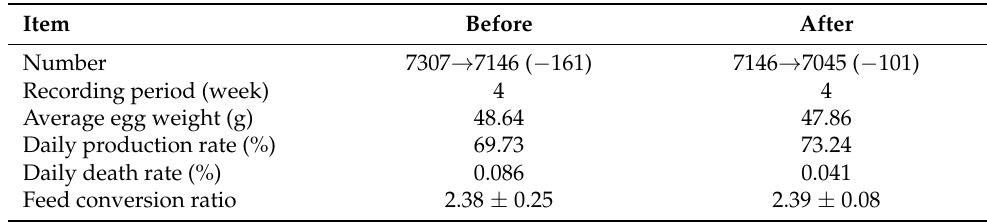
Table 1. ALPS in traditional layer house in Jiuru,